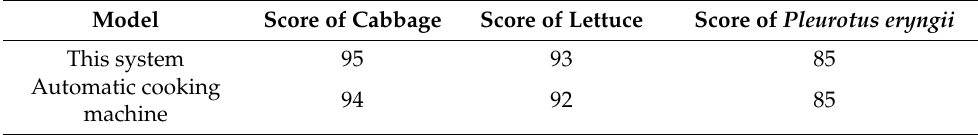
Table 4. Comparison of cooking results between this system and market automatic cooking machines. Model Score of Cabbage Score of Lettuce This